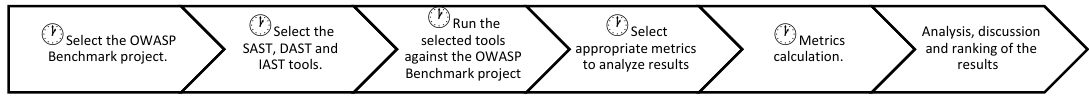
Figure 1. Method proposal to analyze analysis security testing (AST) n-tools combinations.